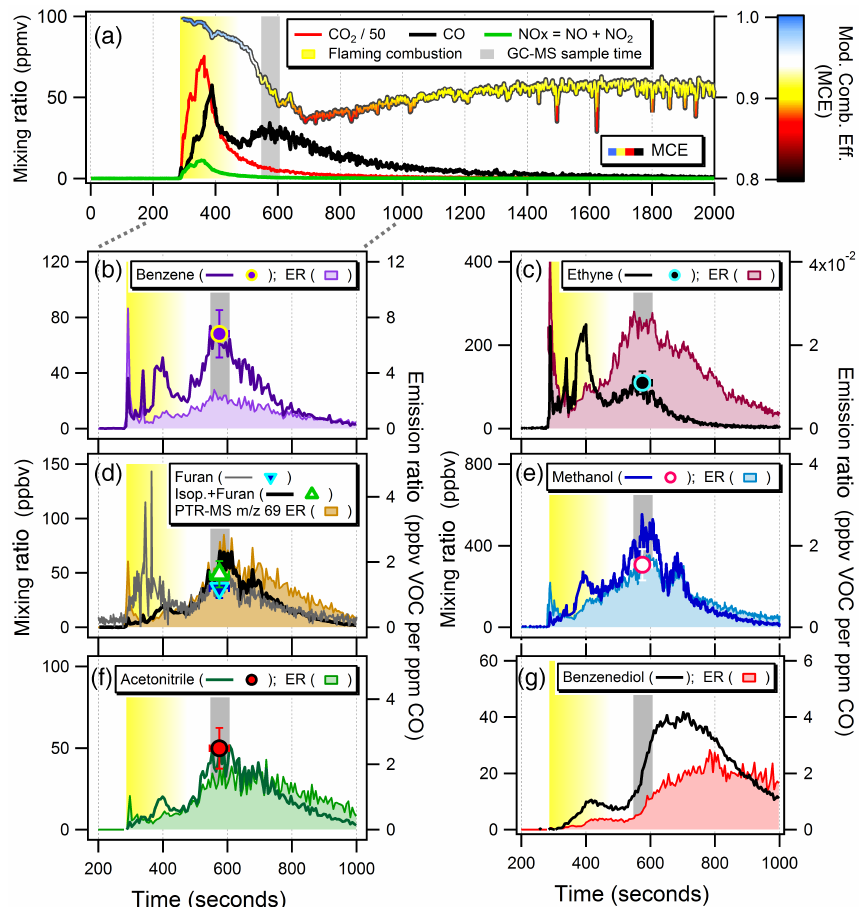
Figure 1. Temporal profiles of mixing ratios and emission ratios (ER) of selected gases and the modified combustion efficiency (MCE) for an example laboratory burn of Emory Oak Woodland fuel from Fort Huachuca, Arizona. (a) Mixing ratios of CO 2 , CO, and NO x measured by OP-FTIR. The MCE trace is colored by the key and scale on the right. The vertical bars represent the flaming combustion phase of the laboratory burn (yellow) and the GC-MS sample acquisition time (grey). (b) – (f) Discrete GC-MS measured mixing ratios are shown as markers. (b) – (g) Mixing ratios measured by PTR-MS (benzene, m/z 69 = isoprene + furan + other, and acetonitrile), OP-FTIR (furan, ethyne, and methanol), and NI-PT-CIMS (benzenediol) are shown as lines and the corresponding VOC to CO ERs are shown as filled